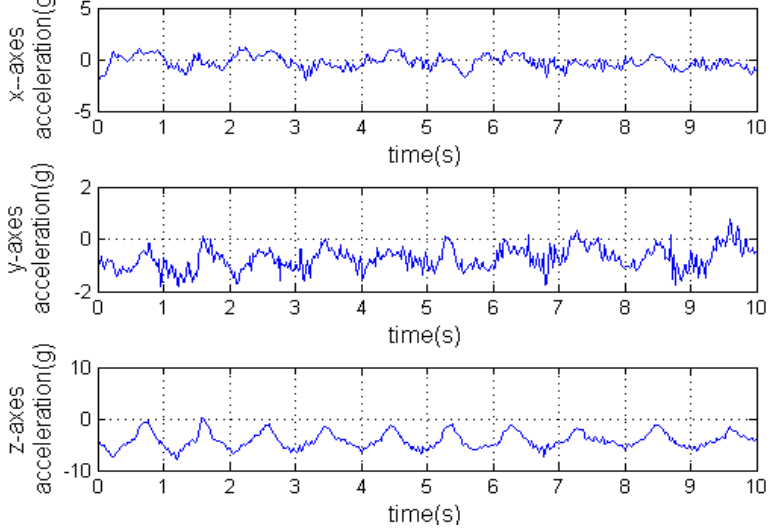
Figure 9. The accelerations with respect to the carrier’s coordinate frame. Sensors 2016 , 16 , 1657